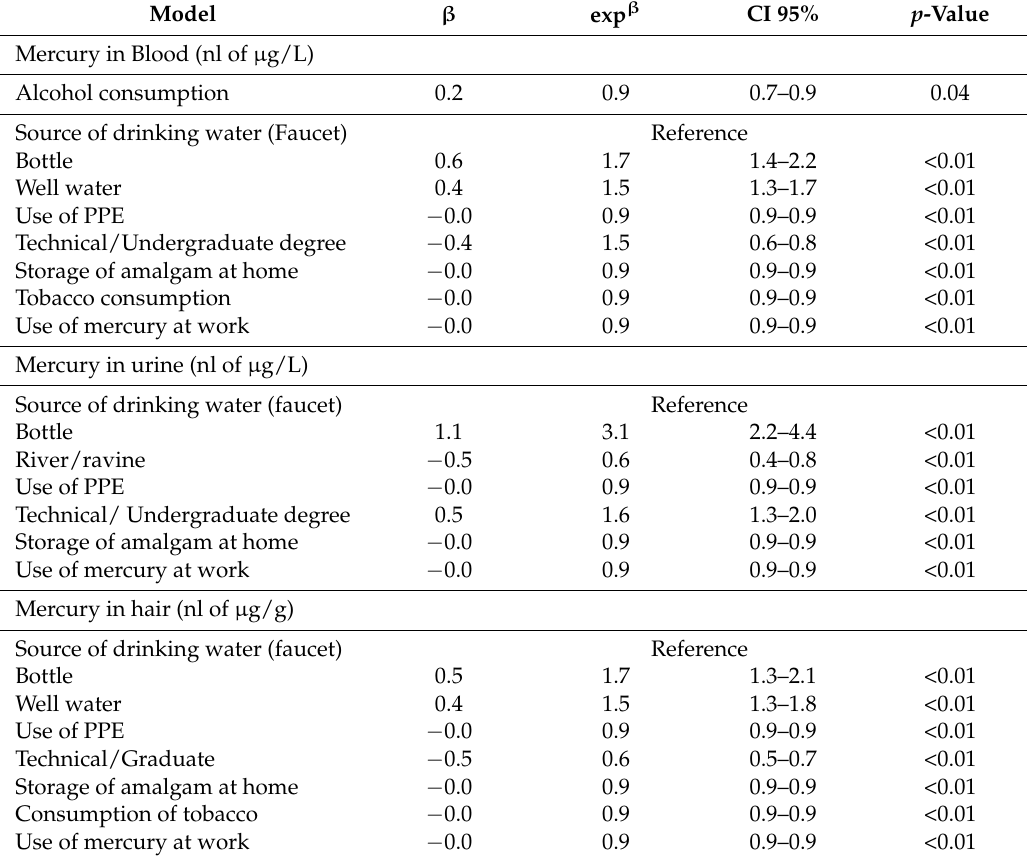
Table 3. The results of the bivariate analysis between independent variables and mercury levels in biological matrices in the La Mojana region, 2015.